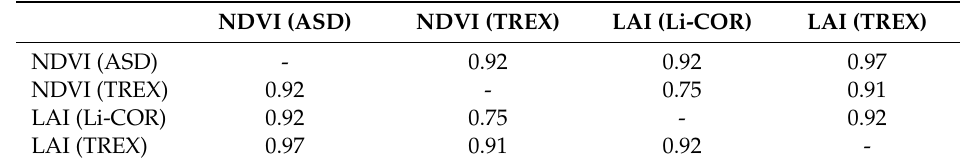
Table 2. Correlation between field measurements (averaged by plot) from 16 July 2015 and maps processed with TREX using five-day synthesized image (16–20.07.2015)